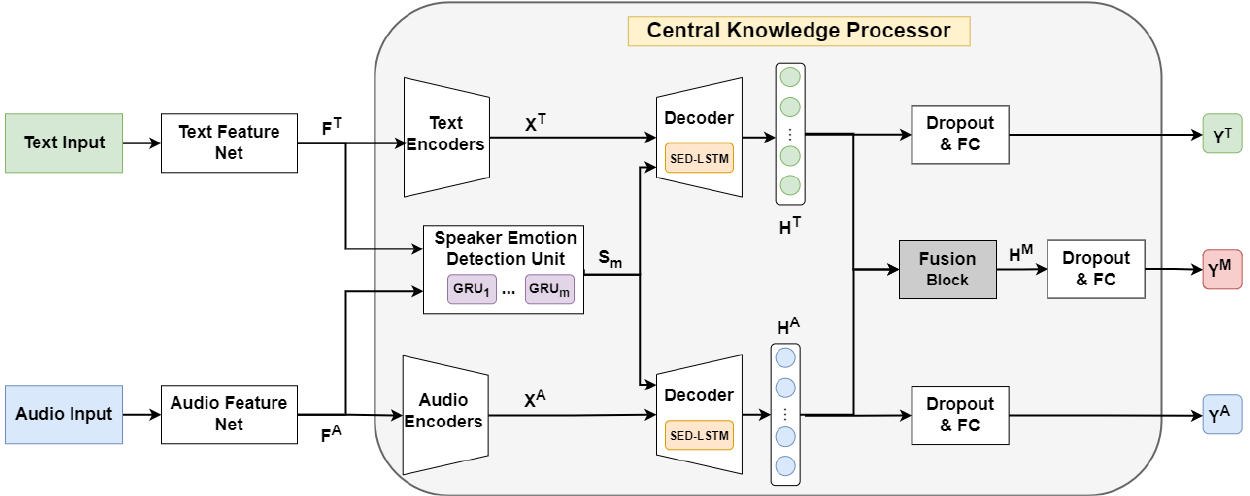
Figure 1. The architecture of the proposed MMATERIC framework. A represents audio modality, and T represents text